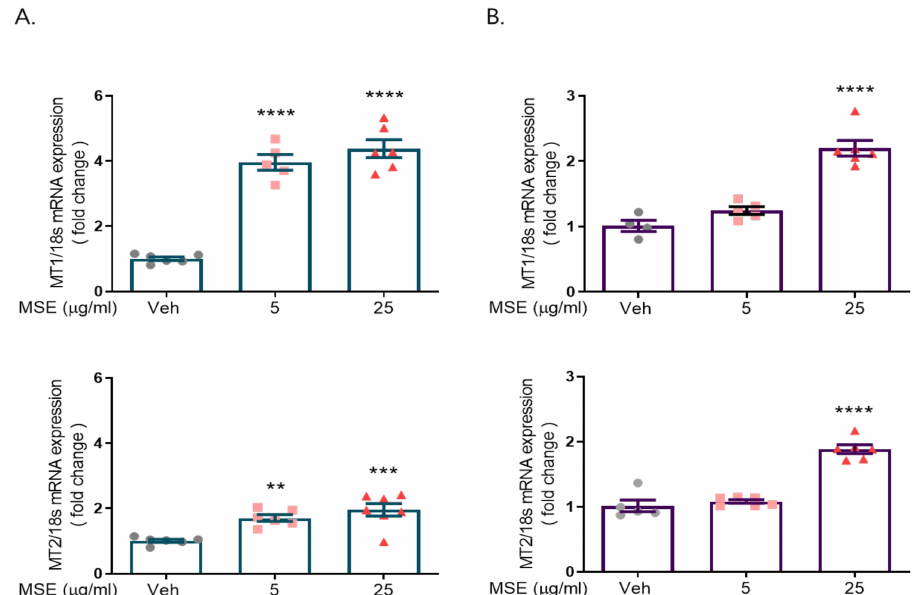
Figure 1. Maydis stigma extracts increase mRNA expression of melatonin receptors 1 and 2. Cultured neurons were treated with MSE (5, 25 µ g/mL) and positive control (valerian root, VR, 10 mg/kg) on DIV 8. After 24 h, qRT-PCR was performed for measuring the mRNA expression of melatonin receptors 1 and 2 in rat primary hypothalamic neurons ( A ) and rat primary cortical neurons ( B ). ** p < 0.01, *** p < 0.001, **** p < 0.0001; Veh vs. MSE (N =